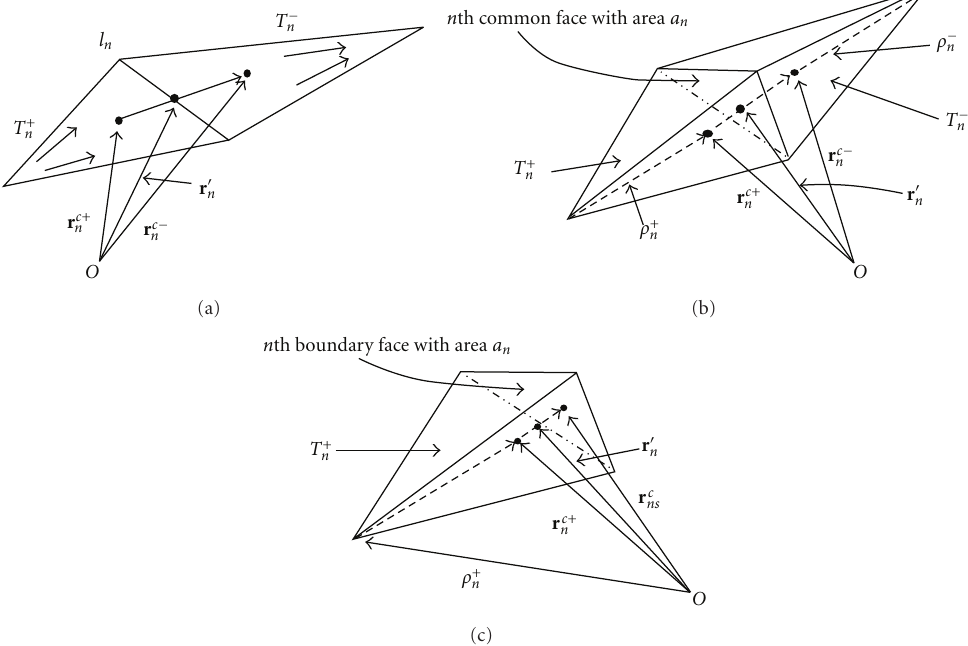
Figure 1: (a) Pair of triangle patches with the n th common edge l n . (b) Pair of tetrahedrons associated with the n th common face. (c) The n th boundary face associated with one tetrahedron.